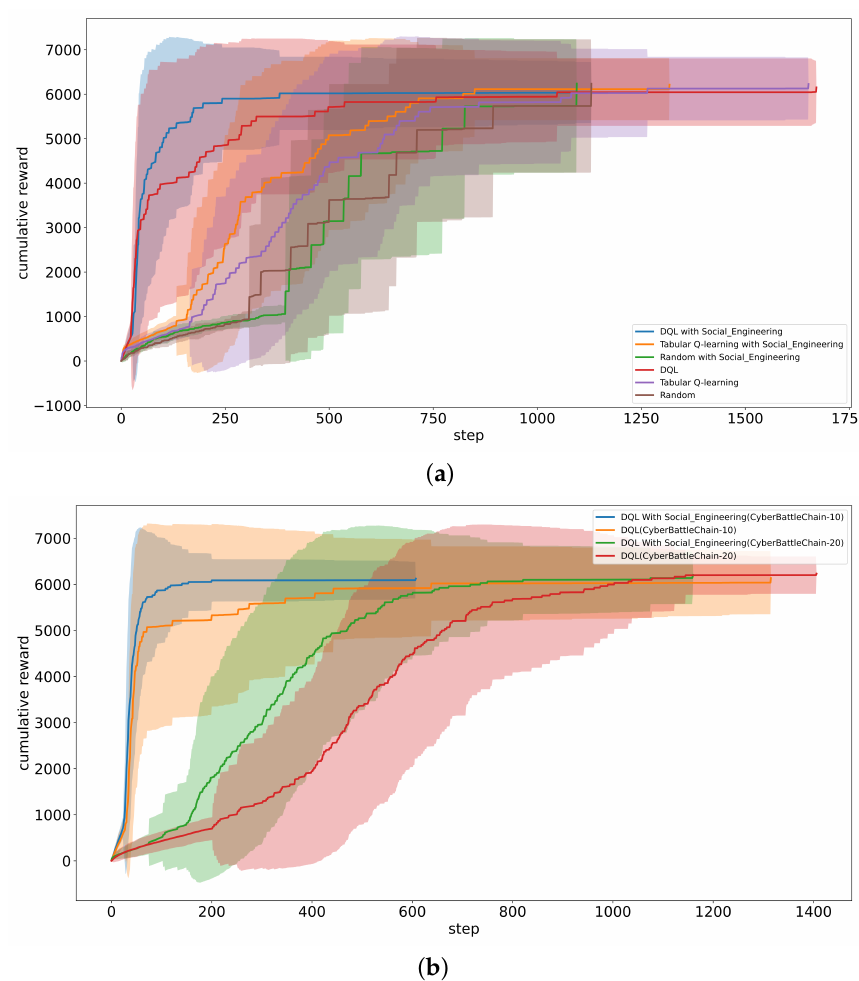
Figure 12. The result of experiment A. ( a ) The average cumulative rewards of the three agents in different training scenarios. ( b ) The average cumulative reward for applying DQL in network scenarios of different